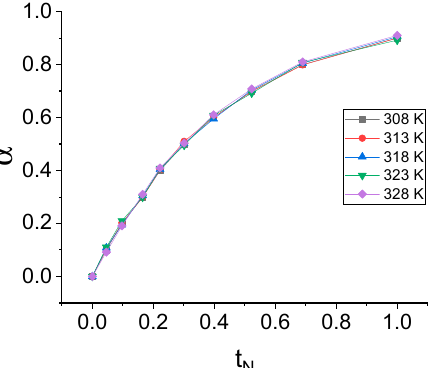
Figure 4. Isothermal normalized conversion curves of NIAM release .